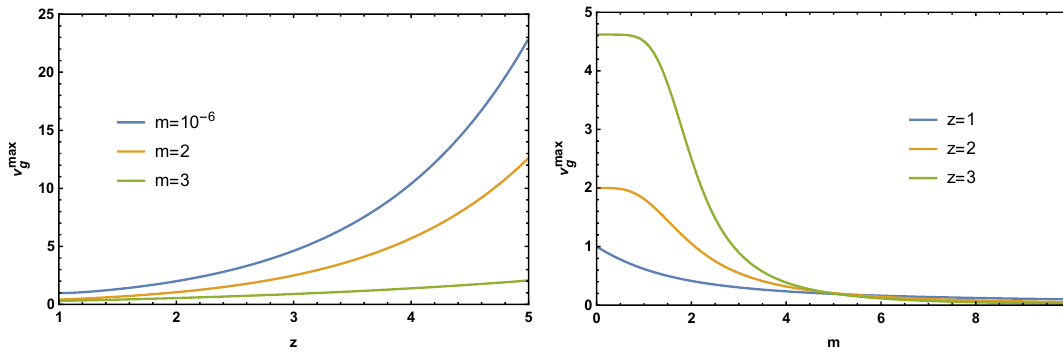
Figure 5 . Left: v max as a function of z for di(cid:11)erent mass parameters. Right: v max g of m for di(cid:11)erent values of the dynamical